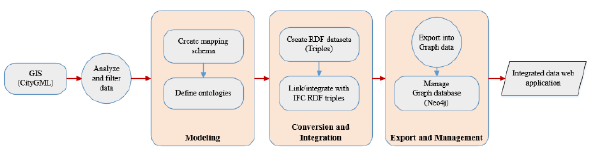
Figure 6. CityGML elements translation and export